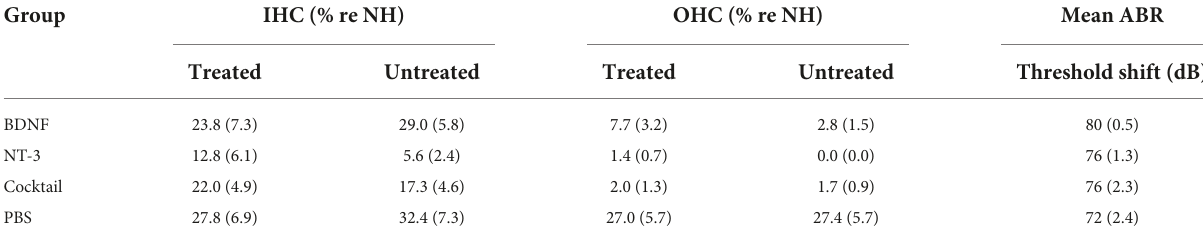
TABLE 1 Mean percentage of remaining inner hair cells (IHCs) and outer hair cells (OHCs) of both the treated and untreated cochleas, and the mean ABR threshold shift, following ototoxic deafening.